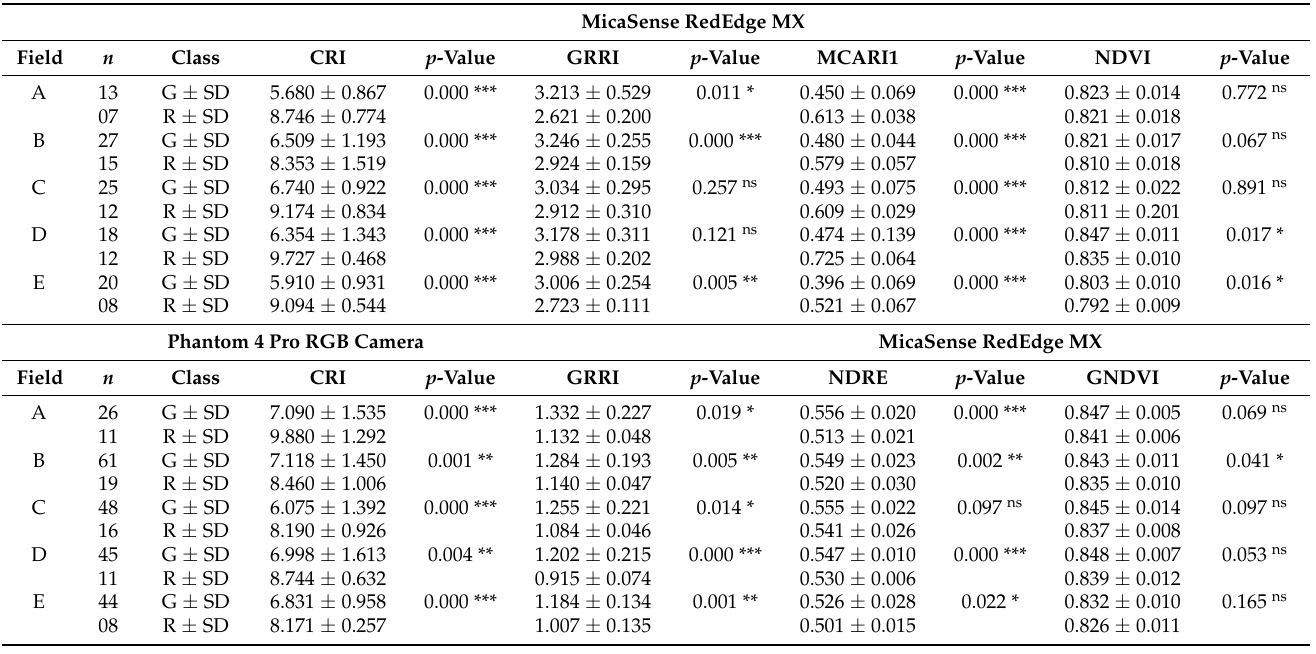
Table 5. Comparison of average values of the vegetation indices from plants with unripe (G) and ripe (R) coffee fruits per